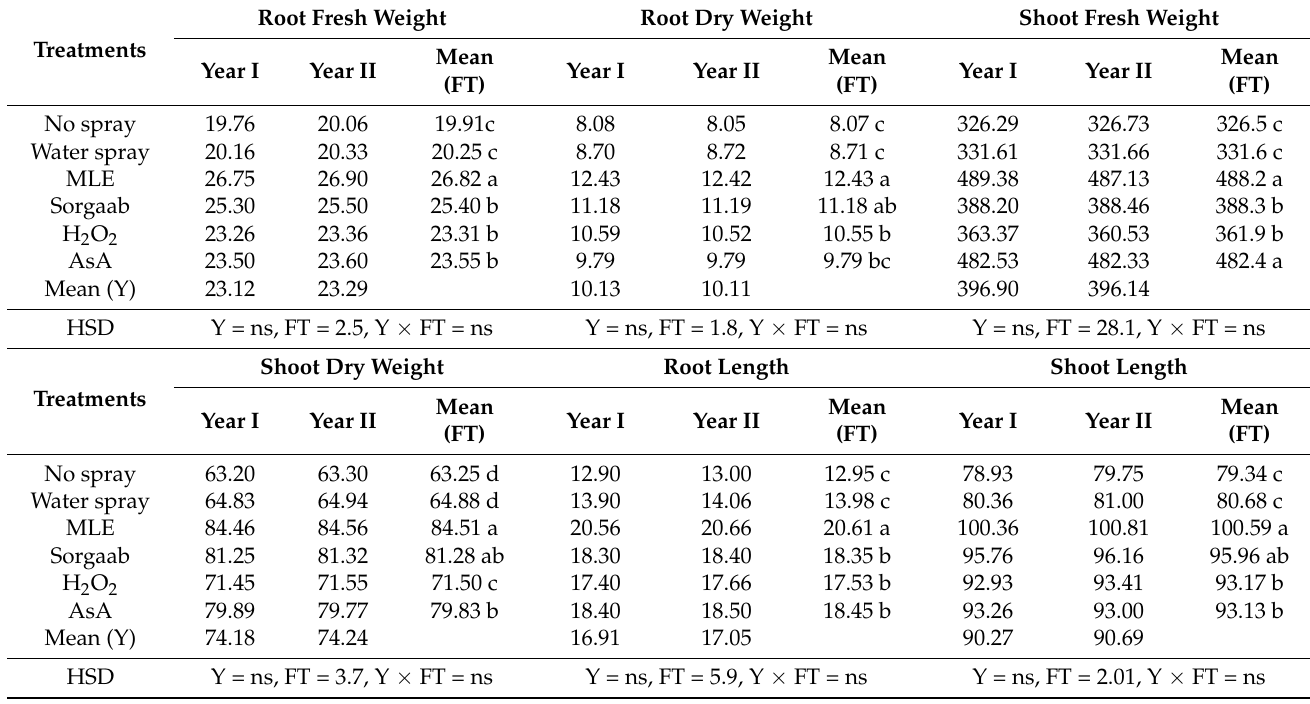
Table 3. Impact of foliar applied plant growth enhancers on growth and yield of quinoa plants cultivated during the growing seasons of 2016–2017 (Year I) and 2017–2018 (Year